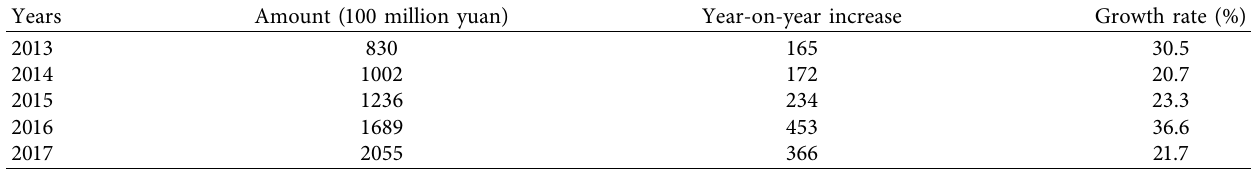
Table 1: Economic growth of the game animation industry from 2013 to 2017.